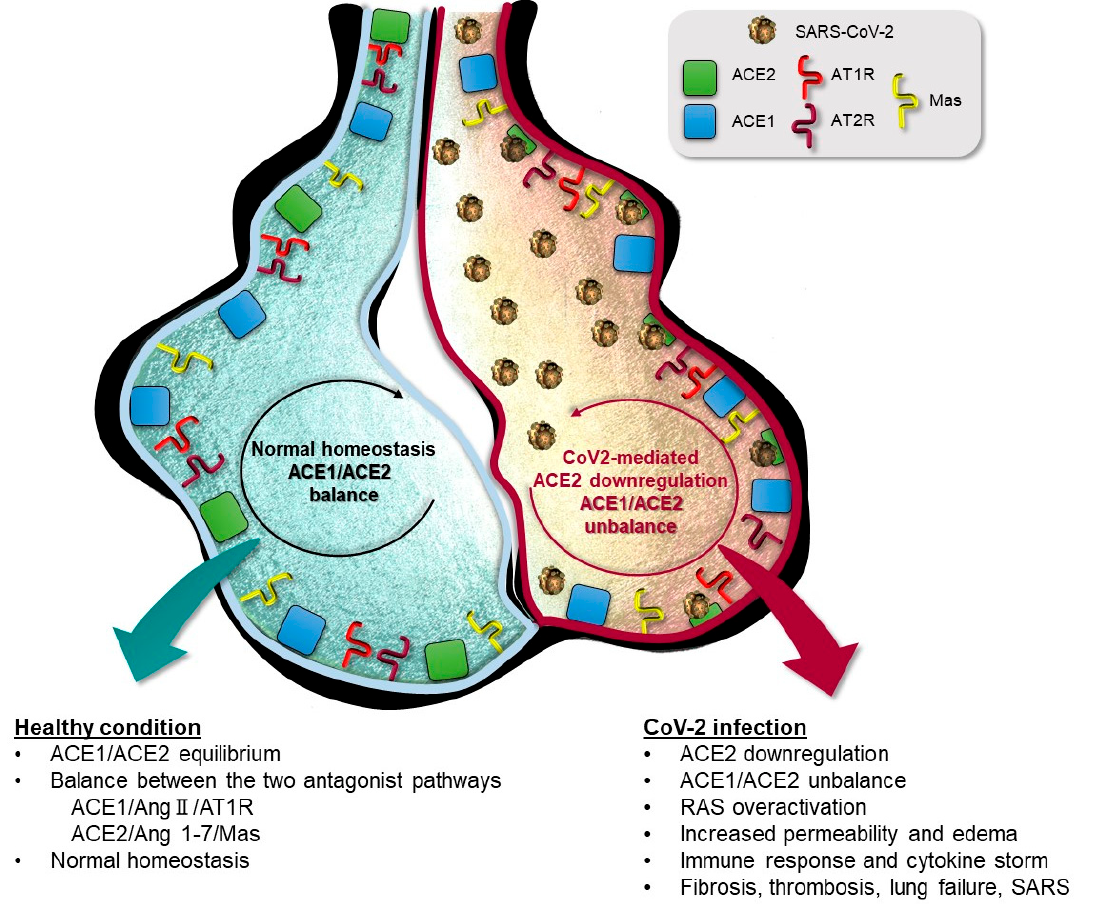
Figure 2. Schematic representation of lung alveolar in presence of normal homeostasis (left) characterized by a balanced ACE1 / ACE2 pathway, and during SARS-CoV-2 infection condition (right) in which SARS-CoV-2 mediated suppression of ACE2 receptor causes ACE1 / ACE2 unbalance responsible for RAS over-activation and pulmonary shut-down.